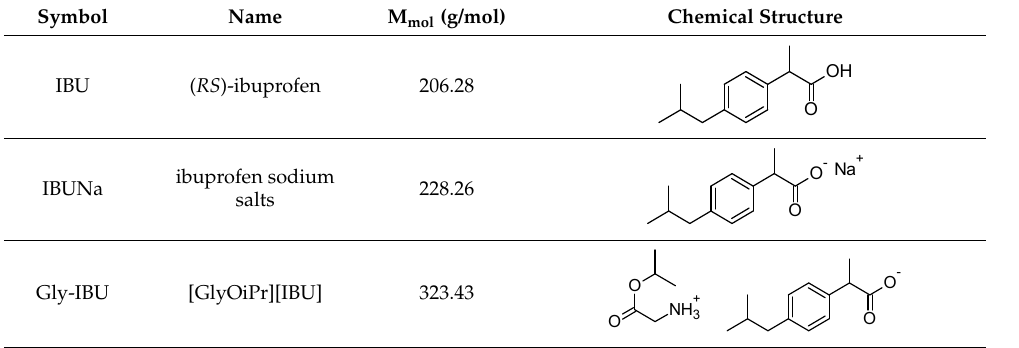
Table 6. Characteristics of the used active substances.